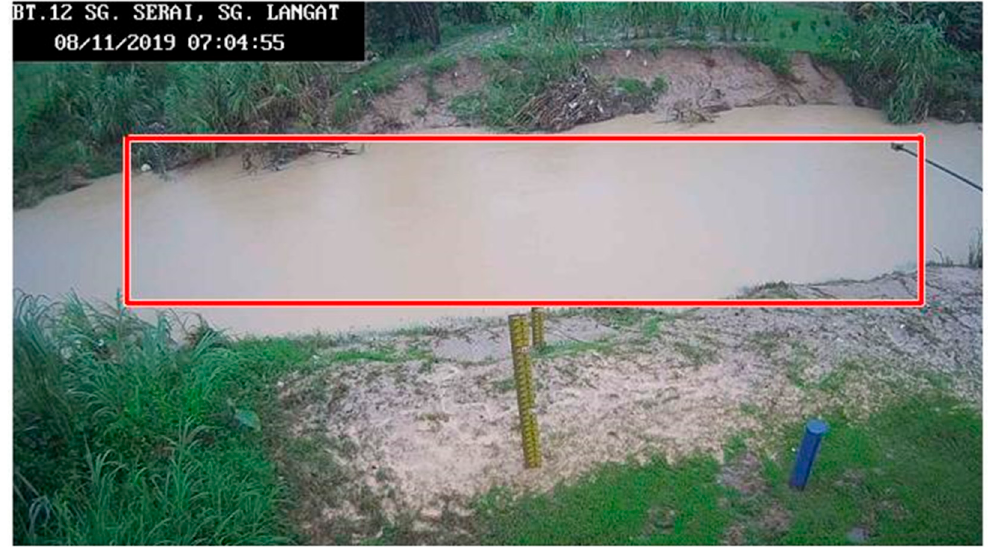
Figure 3. The initial curve in the study area.